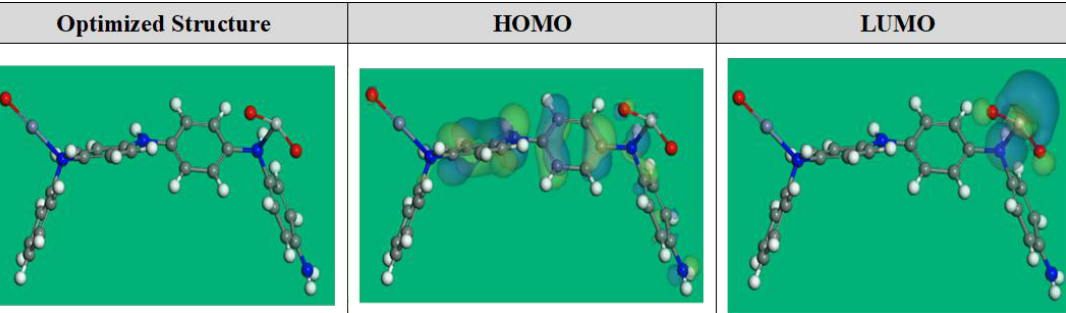
Figure 9. The DFT optimized structure and the occupation of the LUMO and HOMO orbitales for ZnTiO@PANi compound. Table 4. DFT parameters of the studied compounds.